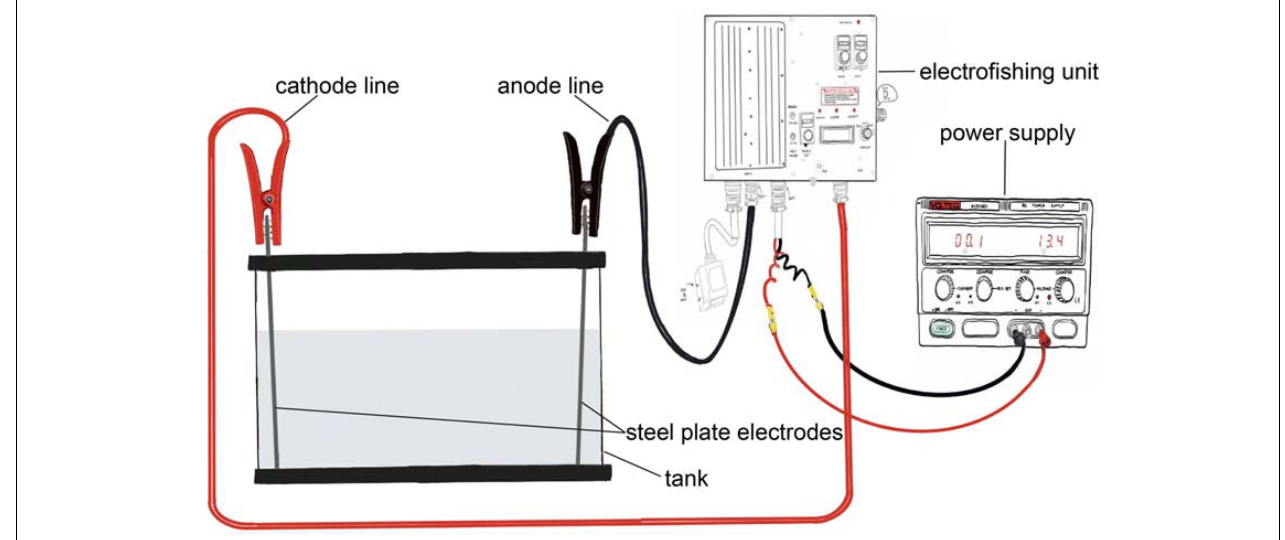
FIGURE 1 | Diagram of experimental electric barrier setup, including power supply, electrofishing unit, tank, steel plate electrodes, and cathode and anode lines.